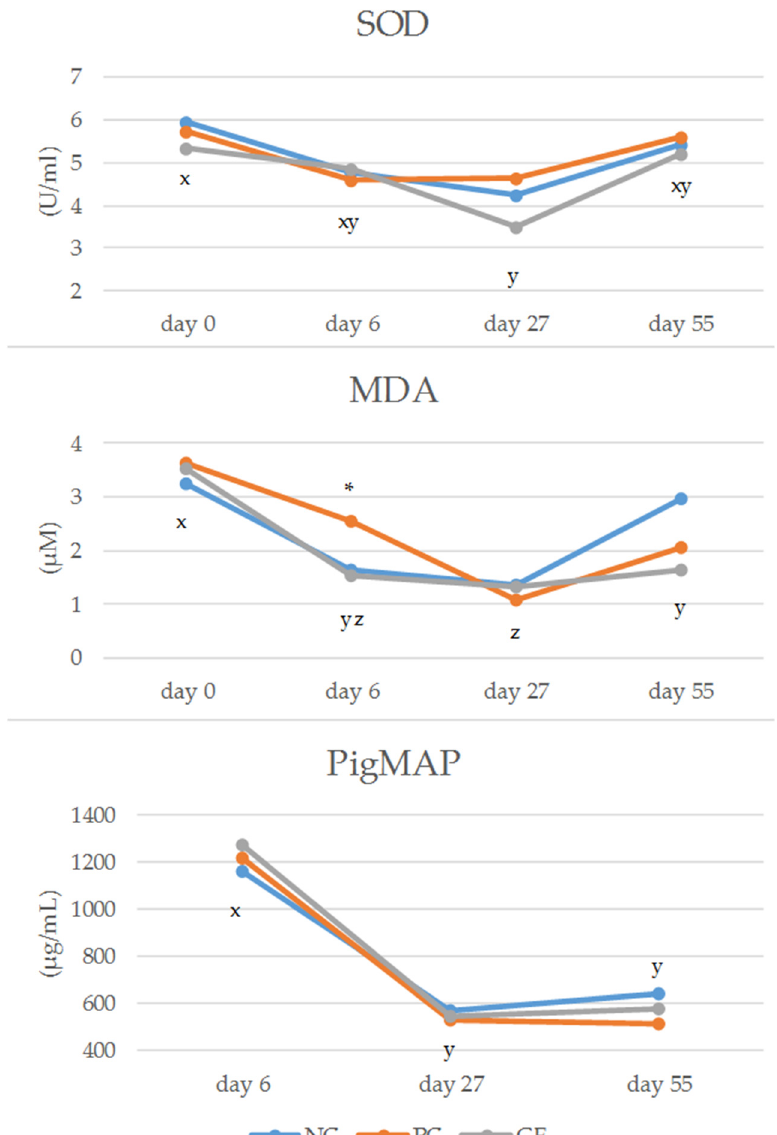
Figure 2. Main effect of sampling day (d) on plasma antioxidant measurements (SOD, superoxide dismutase; MDA, malondialdehyde) and acute-phase proteins (PigMAP (major acute-phase protein). LSMeans of the respective diets are shown for every sampling day. x, y, z: means of the fixed effect sampling day (d) with different letters significantly differ ( p < 0.05). * Effect of the diet observed; further information in Table 10.